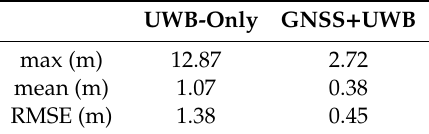
Table 10. Overall 3D positioning